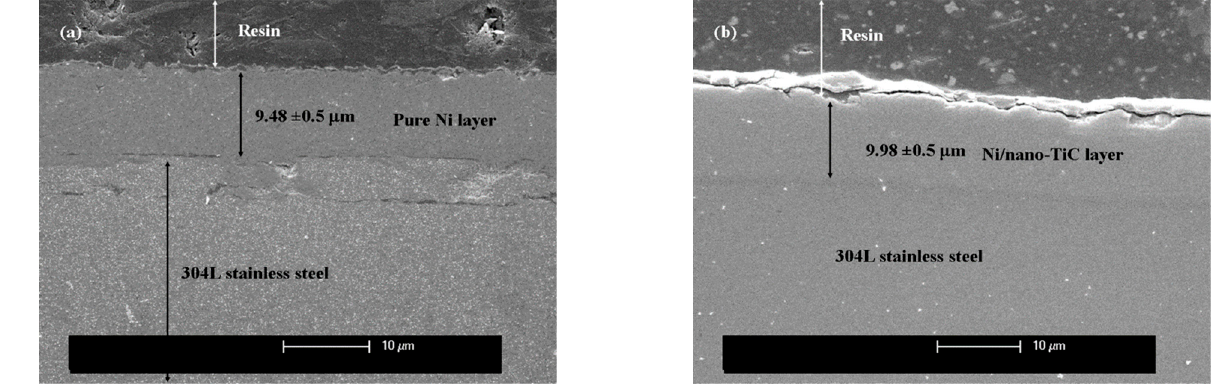
Figure 2. SEM micrographs of layer thickness for: ( a ) the pure Ni layer; ( b ) the Ni/nano-TiC composite layer.